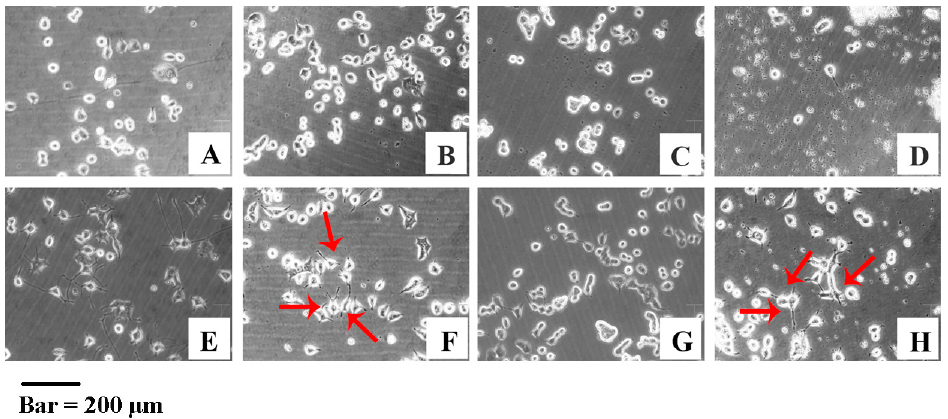
polysaccharide JCS1; ( B ) 5.56; ( C ) 33.33; and ( D ) 55.56 µ M for 120 h; ( E ) PC-12 cells treated with nerve growth factor (NGF) as a positive control; ( F – H ) PC-12 cells incubated with YJCS1 at three different concentrations; ( F ) 5.56; ( G ) 33.33; and ( H ) 55.56 µ M. Represented positive neuritogenesis induced by YJCS1 was indicated by red